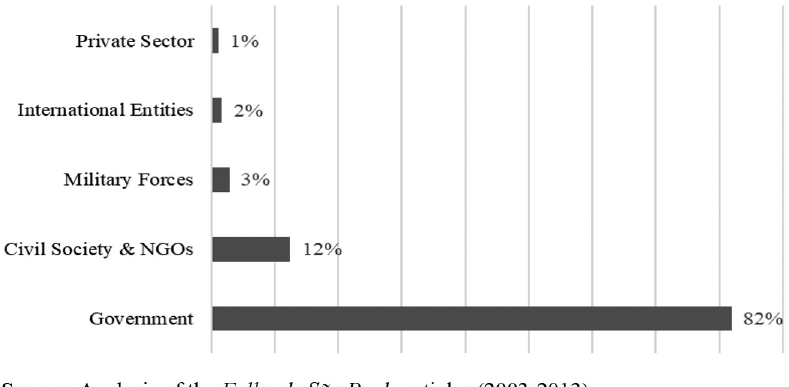
Figure 4. Actors involved in